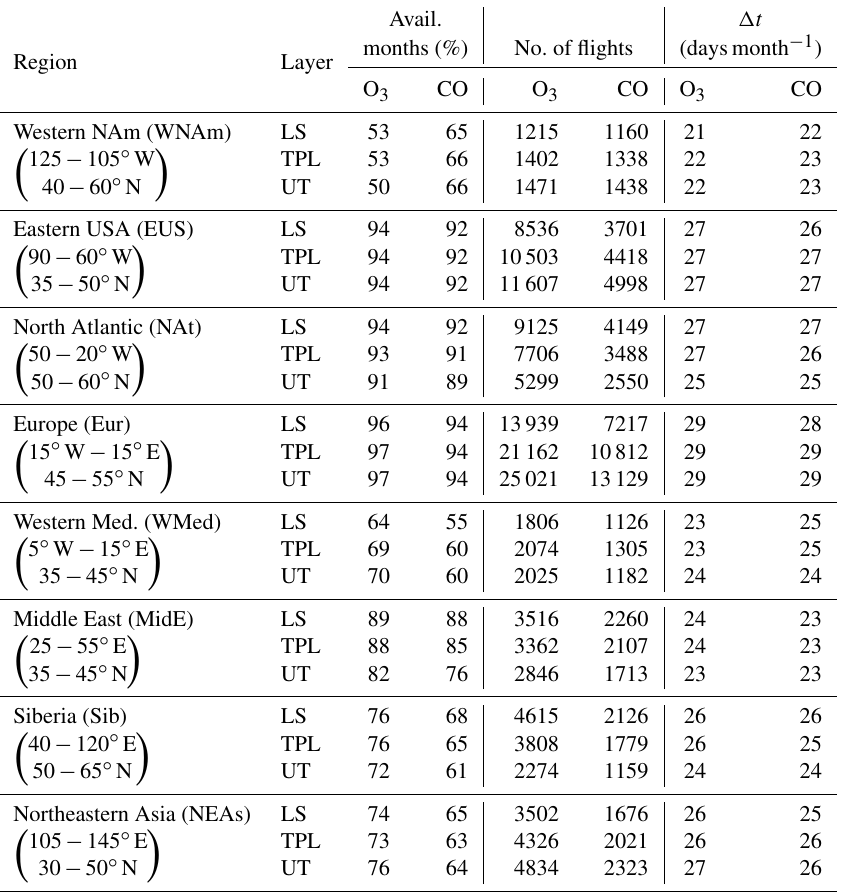
Table 1. Regional characteristics and data statistics in each layer. The third and fourth columns refer to the proportion of available monthly data relatively to the whole period: August 1994–December 2013 for O 3 and December 2001–December 2013 for CO. The fifth and sixth columns indicate the total number of selected flights. The seventh and eighth columns show the time interval (cid:49)t separating the first and the last days of measurements, averaged over the available data months.